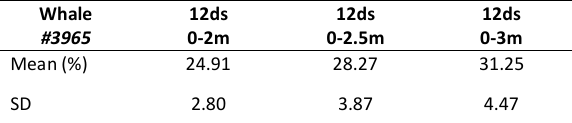
dives below 2 m ( t d ) for the 23 whales from East Greenland with high resolution dive records.